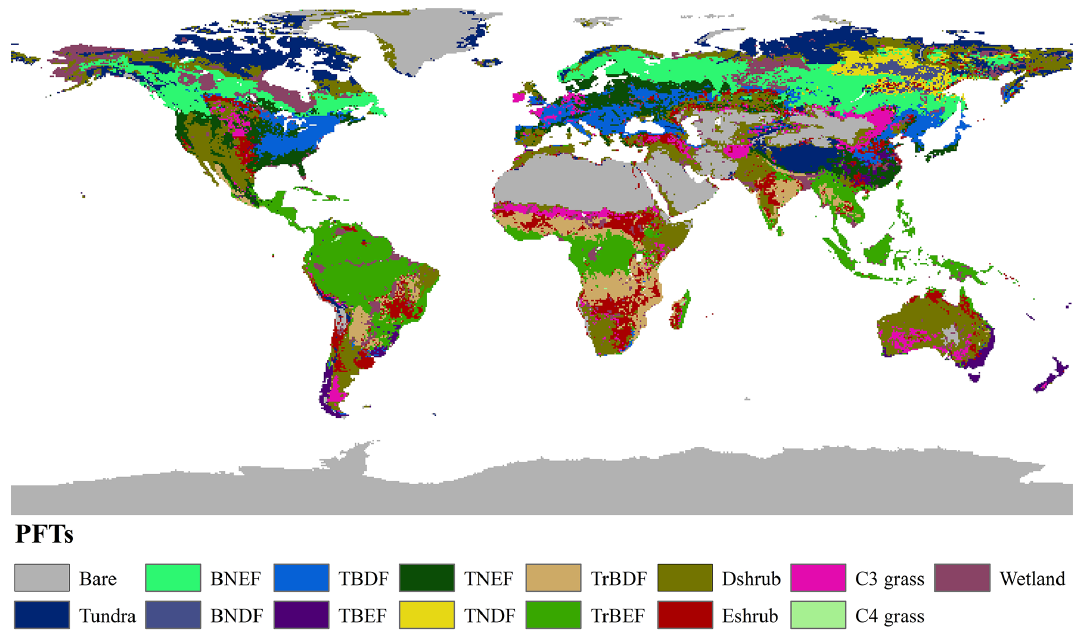
Figure 1. Global potential natural vegetation map used by DLEM in the preindustrial era. BNEF: boreal needleleaf evergreen forest; BNDF: boreal needleleaf deciduous forest; TBDF: temperate broadleaf deciduous forest; TBEF: temperate broadleaf evergreen forest; TNEF: tem- perate needleleaf evergreen forest; TNDF: temperate needleleaf deciduous forest; TrBDF: tropical broadleaf deciduous forest; TrBEF: tropi- cal broadleaf evergreen forest; Dshrub: deciduous shrubland; Eshrub: evergreen shrubland.